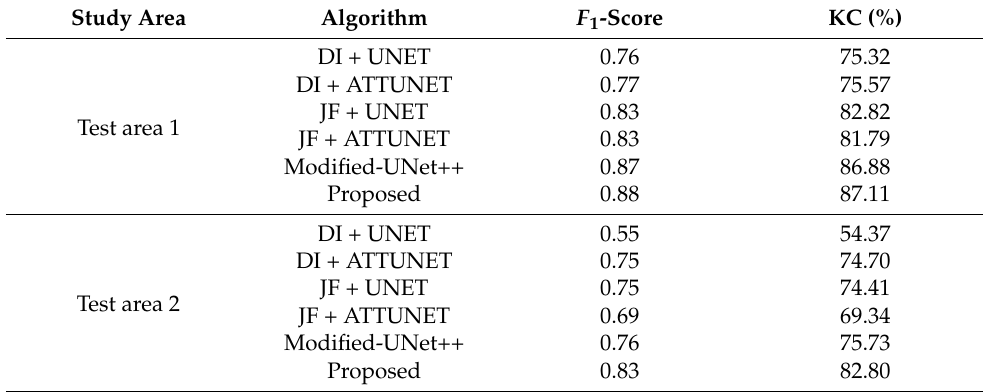
Figure 19. Changed detection maps of the proposed and conventional algorithm for “Test area 4” in the reversed image order: ( a ) Image P; ( b ) Image C; ( c ) Ground truth; ( d ) DI + UNet; ( e ) DI+ ATTUNet; ( f ) JF + UNet; ( g ) JF + ATTUNet; ( h ) Modified-UNet++; ( i ) Proposed bilateral U-Net. Table 2. F 1 -score and KC of the conventional and proposed algorithms for the KOMPSAT-3 dataset. Study